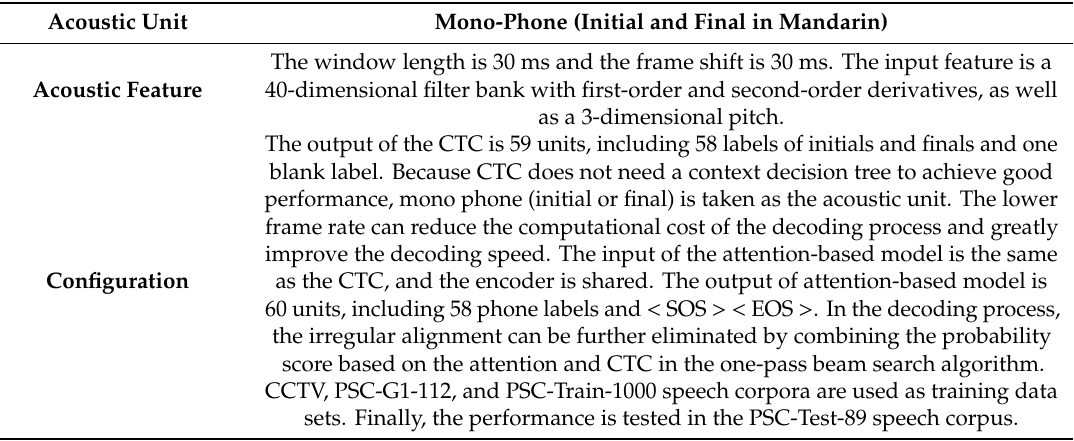
Table 4. Experimental configuration of CTC